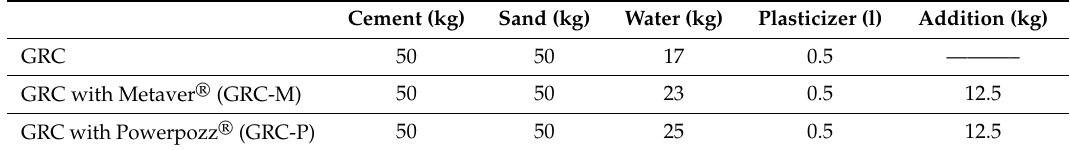
Table 2. Glass-fibre reinforced cement GRC mix proportioning.